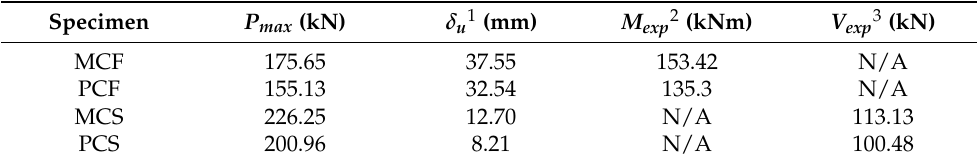
Table 3. Summary of the test results.